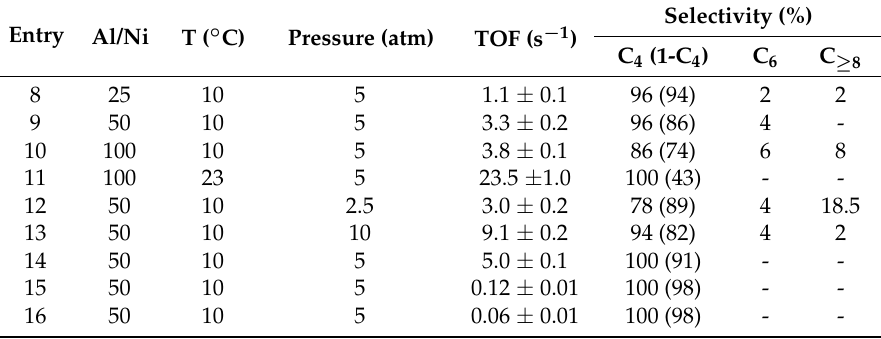
Table 5. Results of catalytic tests of the complex supported on β -zeolite modified with ionic liquid.